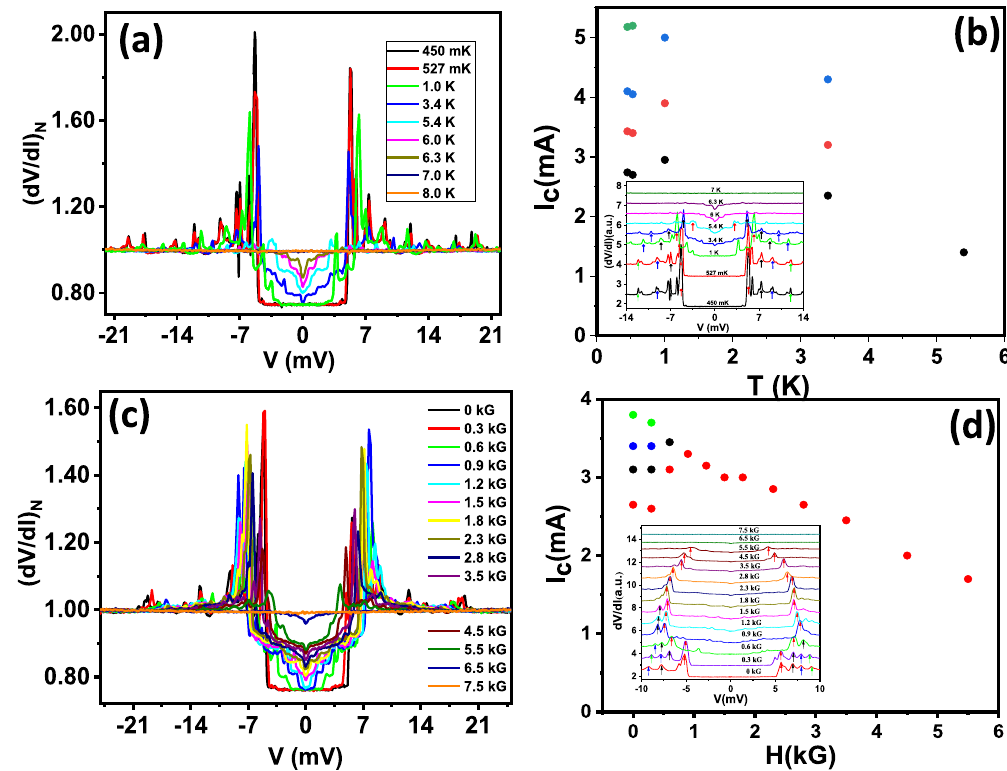
Figure 5. ( a ) Temperature dependence of the spectrum shown in Fig. 4a. ( b ) Temperature dependence of the critical current corresponding to the peaks structure ( I c ) vs. T extracted from the data in ( a ). Inset shows the critical current peak position marking with coloured arrows. ( c ) Magnetic field dependence of the spectrum shown in Fig. 4a. ( d ) Magnetic field dependence of the critical current corresponding to the peaks structure ( I c ) with H extracted from the data in ( c ). The inset shows the multiple critical current peaks (marked with coloured arrows).